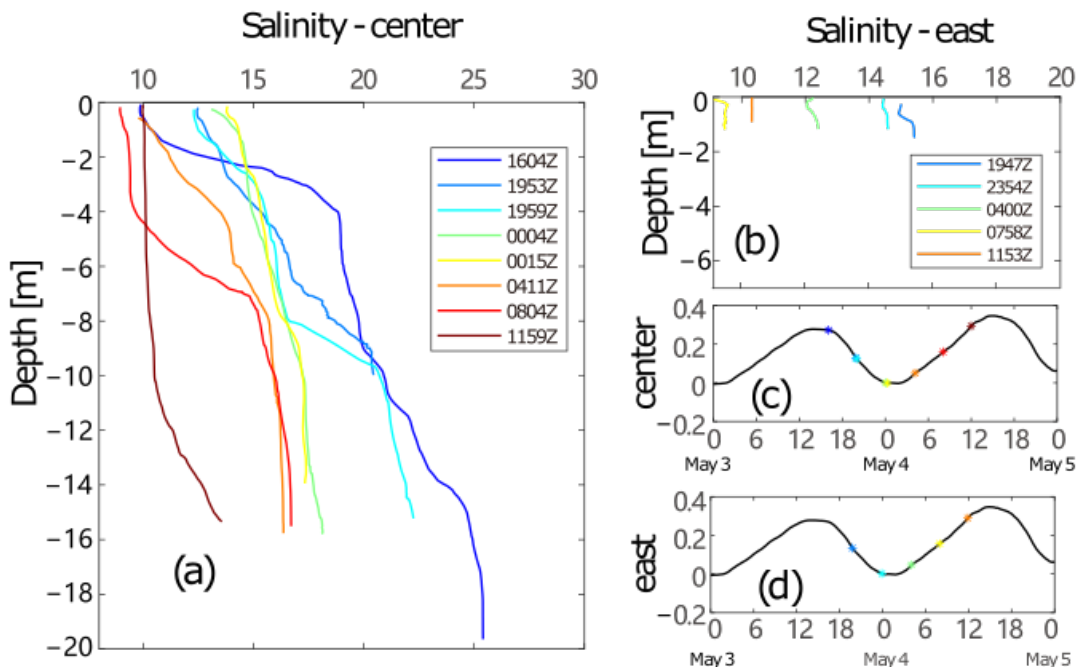
Figure 7. Salinity casts during the investigation in May 2015 in central deep water ( a ) and eastern shallow water ( b ), and water levels labeled with times of central casts ( c ) and eastern casts ( d ).